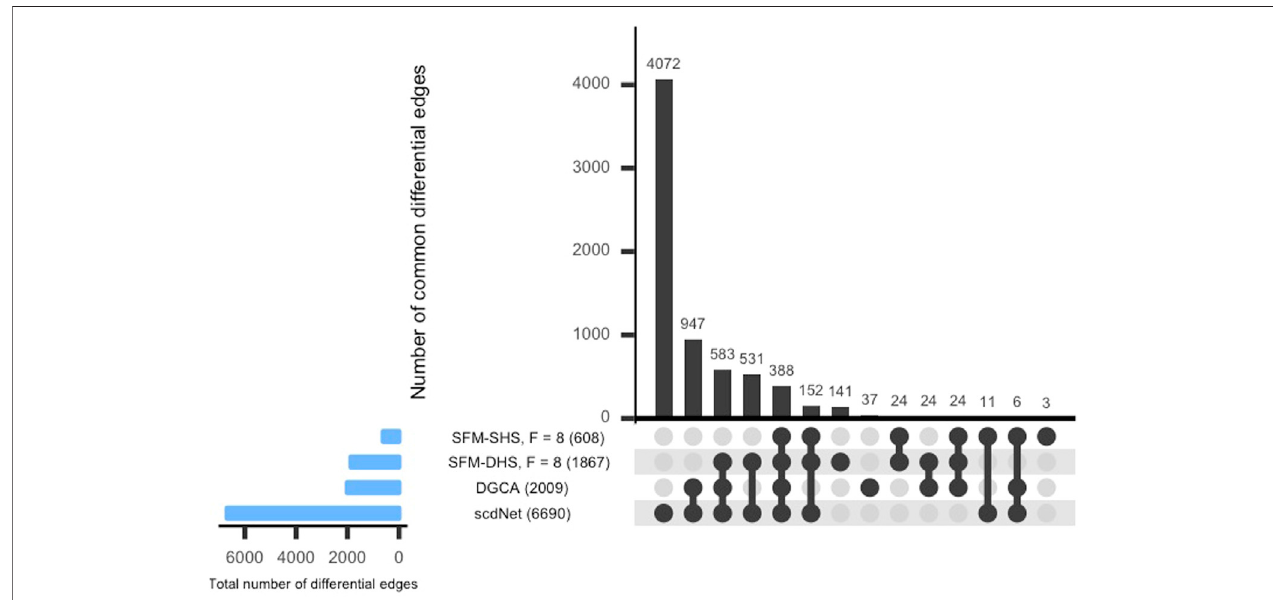
FIGURE4| UpSetplotofthenumberofdifferentialedgesdetermined byfourdifferentialnetworkmethodsintheSARS-CoV-2casestudydataset.Thenumbersin parentheses represent the total number of differential edges detected by the corresponding method. Results displayed for SFM-SHS and SFM-DHS are from the bootstrap estimation